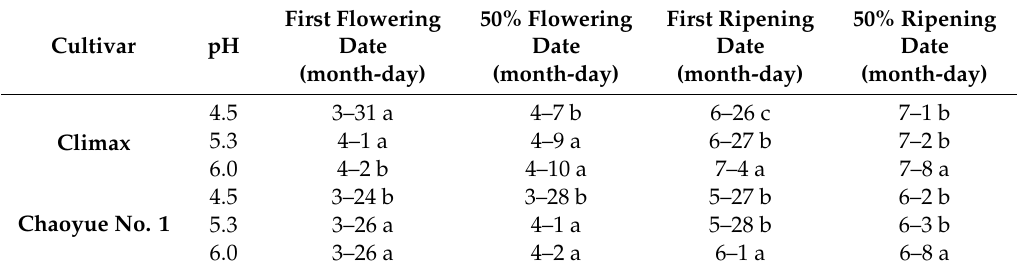
Table 3. E ff ect of di ff erent pH treatments on the flowering and fruit phenological period of two